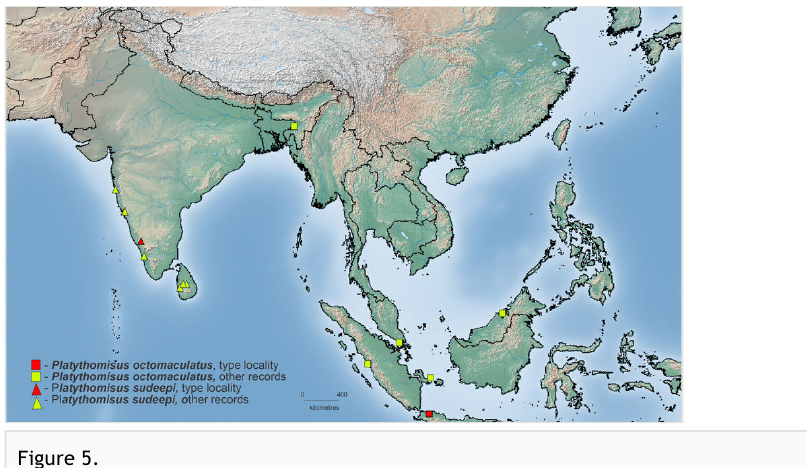
Map showing distribution of Platythomisus octomaculatus and Platythomisus sudeepi